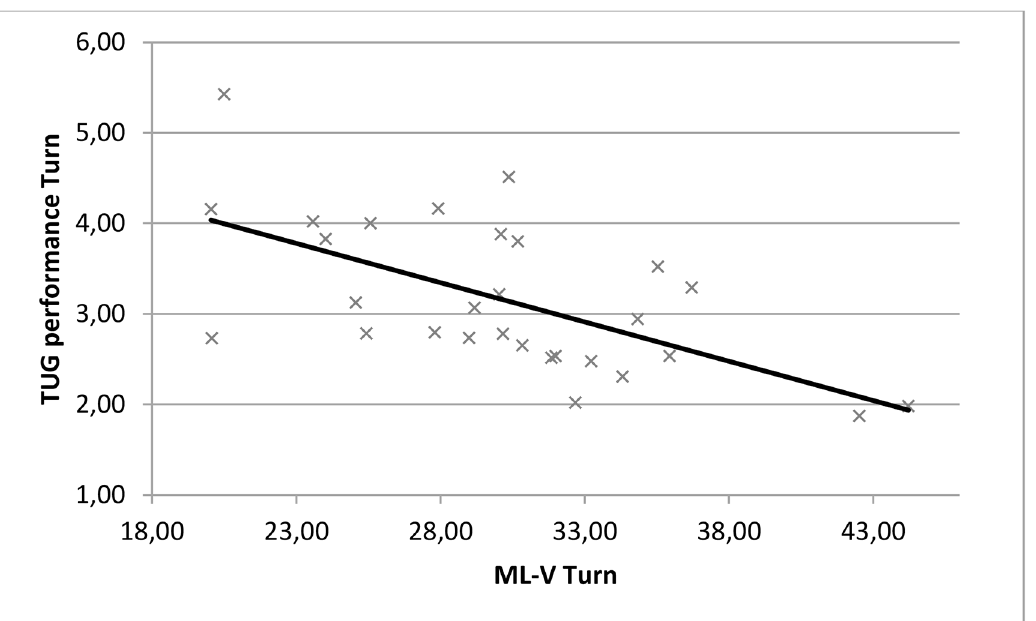
Fig 3. Correlation between ML COM velocity and TUG performance time during the turning sub-task in hemiparetic